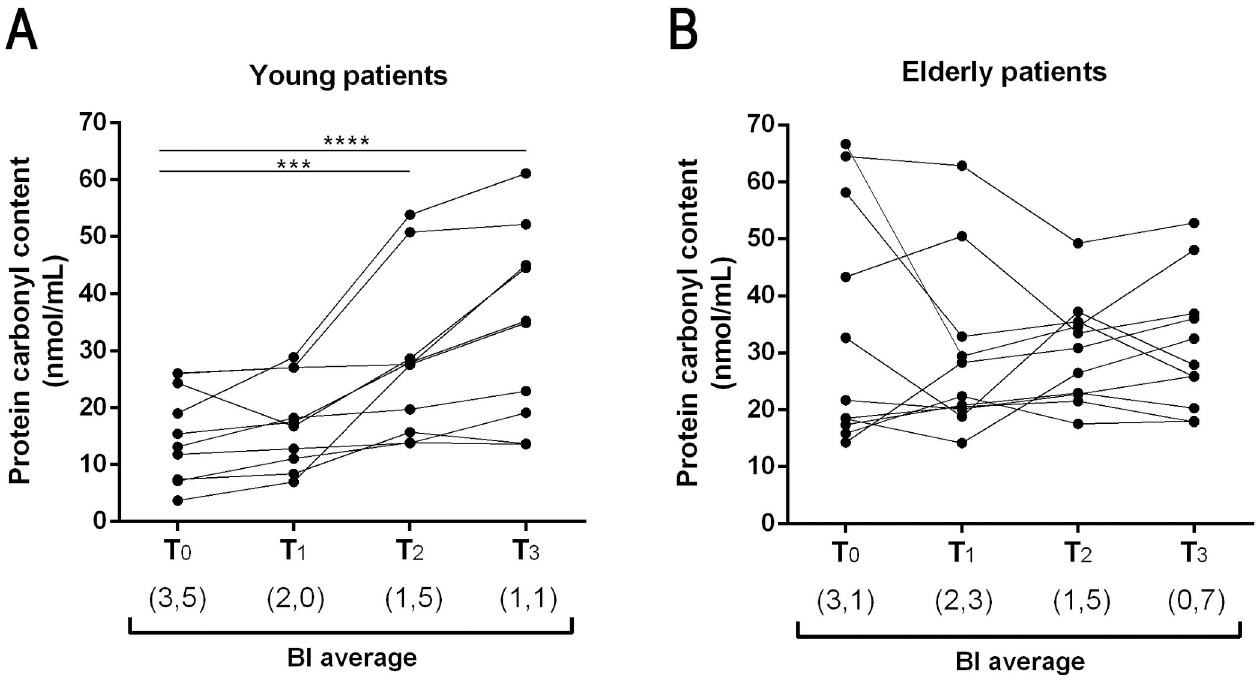
Fig 2. Increase in serum protein carbonyl concentration one year after multidrug therapy (MDT) discharge in the young L-Lep group. (A) Effects of treatment on oxidative stress in Y L-Lep patients (n = 9) and (B) in E L-Lep patients (n = 10): T0 –at diagnosis, before starting MDT; T1—discharge after treatment; T2—one year after discharge; T3—two years after discharge. Each circle represents a patient and lines represent the follow up. The Friedman test was performed to evaluate significant differences between the beginning of MDT and the years following discharge. Values in parenthesis refer to the BI average for each time point. ��� P < 0.001 and ���� P =